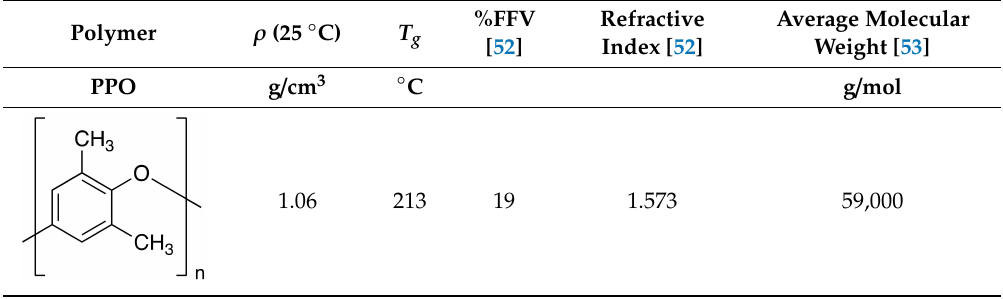
Table 1. Bulk physical properties of amorphous poly(2,6-dimethyl-1,4-phenylene oxide)